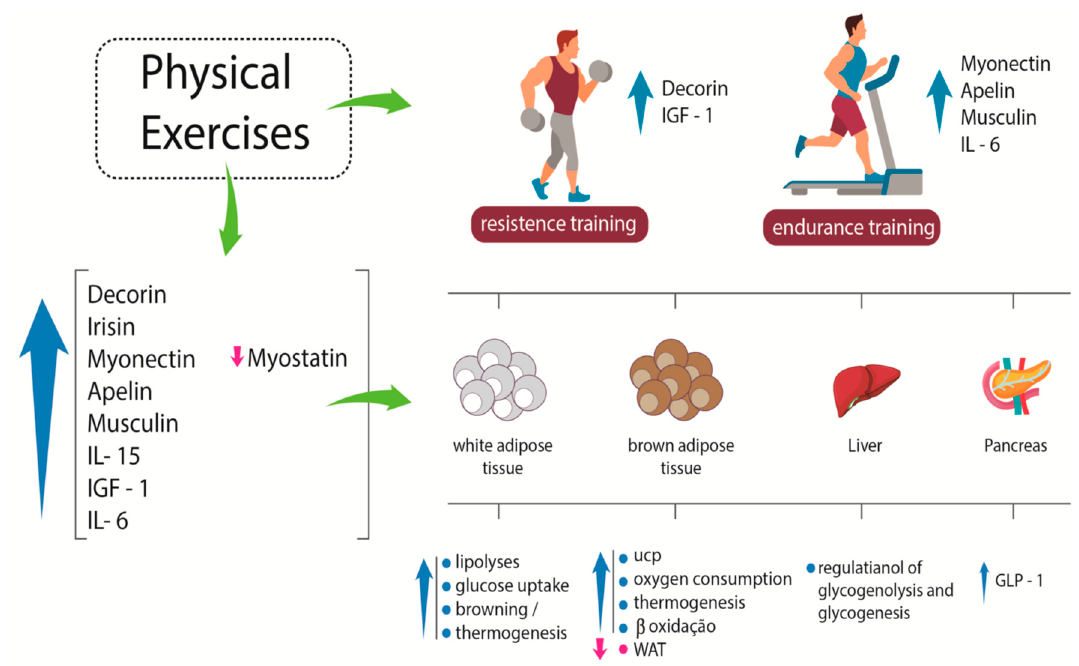
Figure 1. Systemic effects of some myokines. After resistance exercise, specific myokines, such as decorin and IGF-1, are released; after endurance training, other specific myokines, such as myonectin, apelin, musclin, and IL-6, are produced and play different roles in different tissues. IGF-1: insulin-like growth factor-1; IL-6: interleukin-6; IL-15: interleukin-15; UCP: uncoupling protein; WAT: white adipose tissue; GLP-1: glucagon-like peptide-1. Up arrows indicate increase; down arrows indicate reduction.